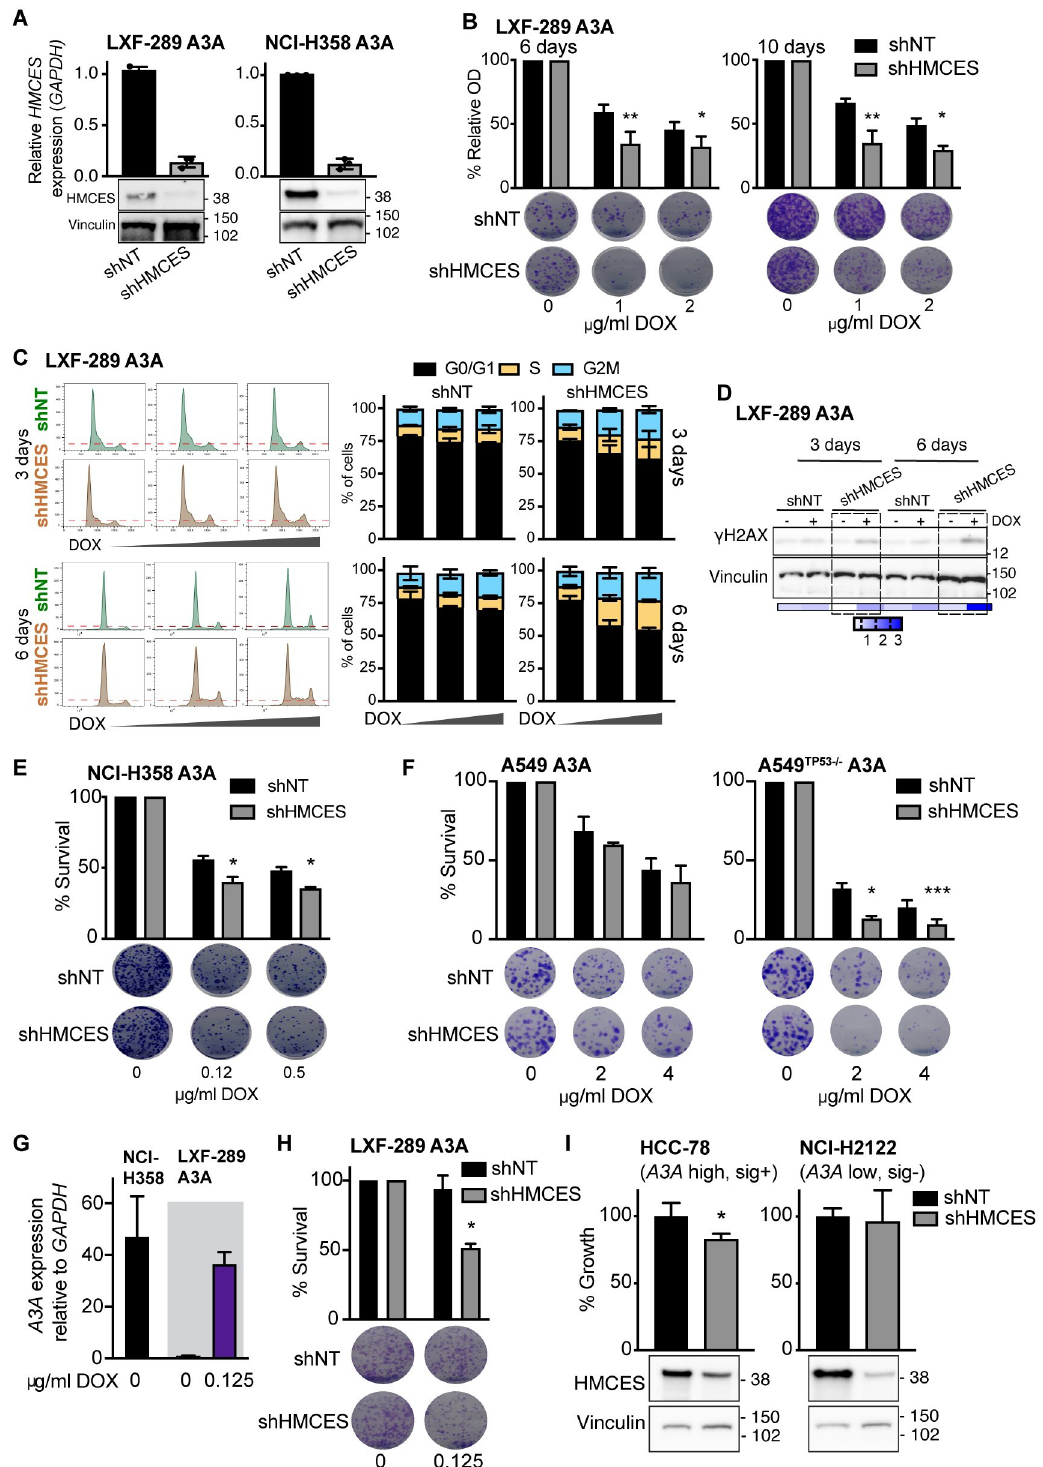
Fig 4. Validation of the effects of HMCES depletion in multiple genetic backgrounds. ( A ) HMCES levels in LXF-289 A3A and NCI-H358 A3A cell lines by qRT-PCR and western blot following transduction with shHMCES or a shNT. The qRT-PCR validation was repeated at least 3 times. Molecular mass is indicated in kilodaltons. ( B ) Reduction of HMCES sensitizes LXF-289 A3A cells to A3A expression in a growth assay for 6 and 10 days (repeated 3 times). ( C ) Representative histograms of cell